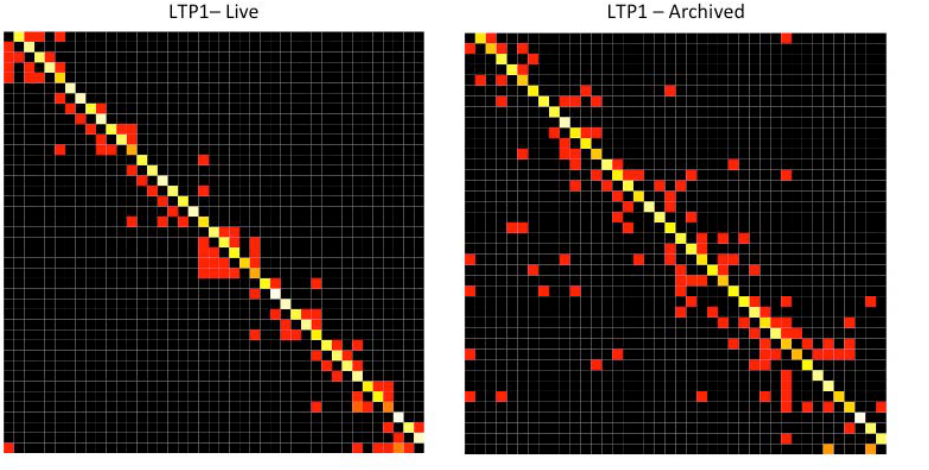
Figure 6. Video transition matrices for LTP1, intent category most.